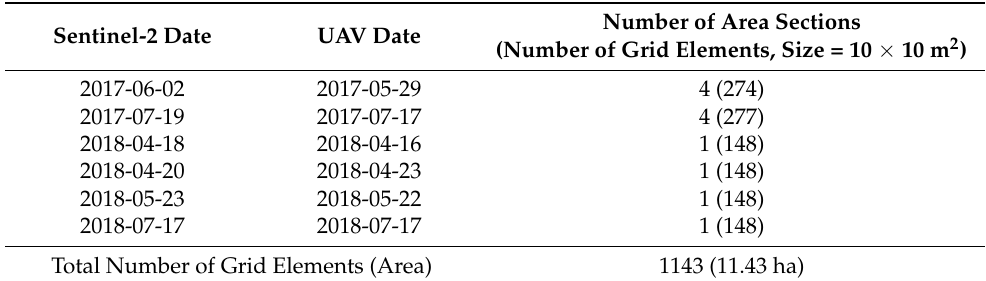
Table A1. Acquisition dates and data volume for the calibration of the GAI-models.